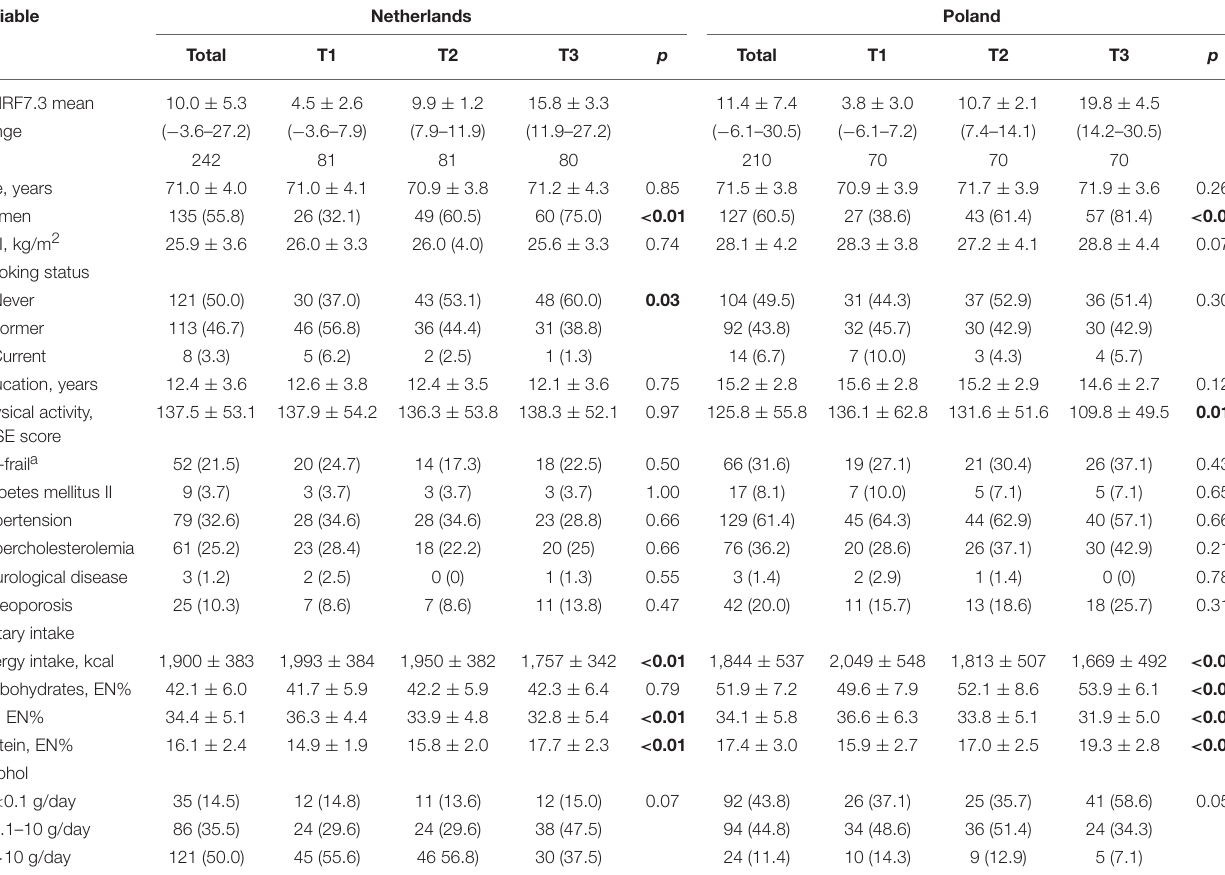
TABLE 3 | General characteristics of 242 Dutch and 210 Polish NU-AGE participants across tertiles of the Elderly Nutrient-Rich Food (E-NRF7.3) score.